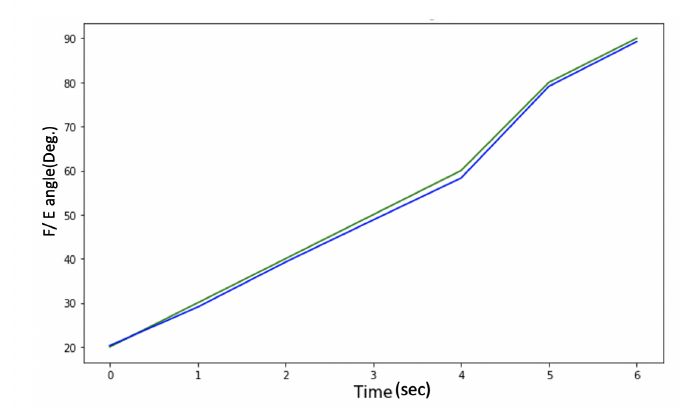
Figure 13. Protractor with arm vs. HeadUp.